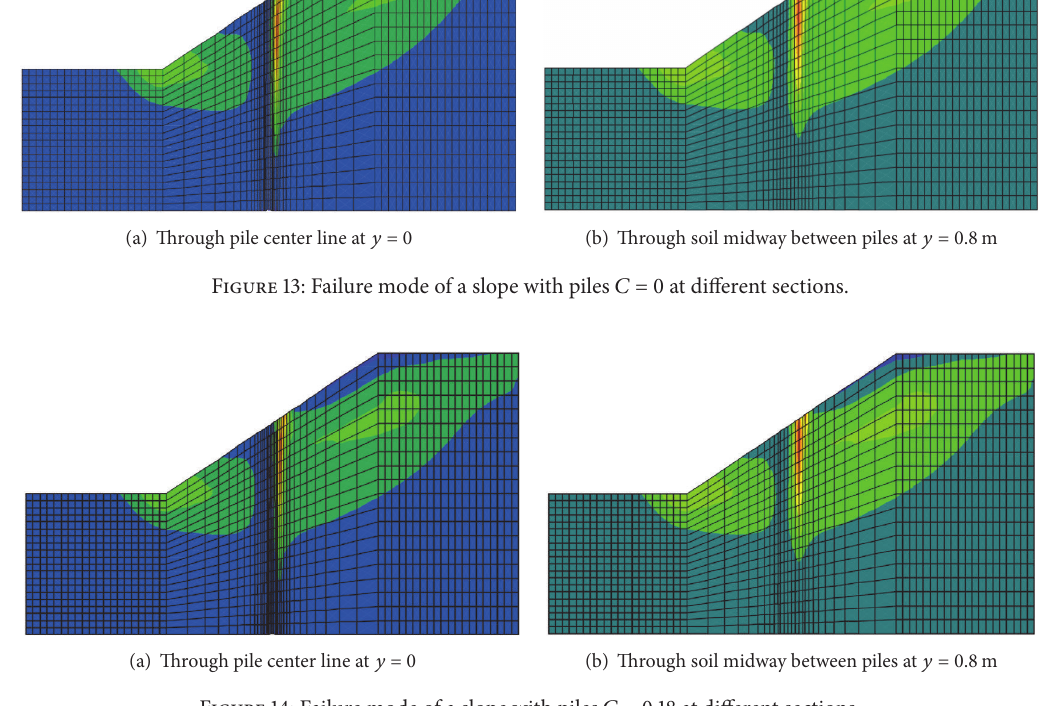
Figure 14: Failure mode of a slope with piles 𝐶 = 0.18 at different sections.